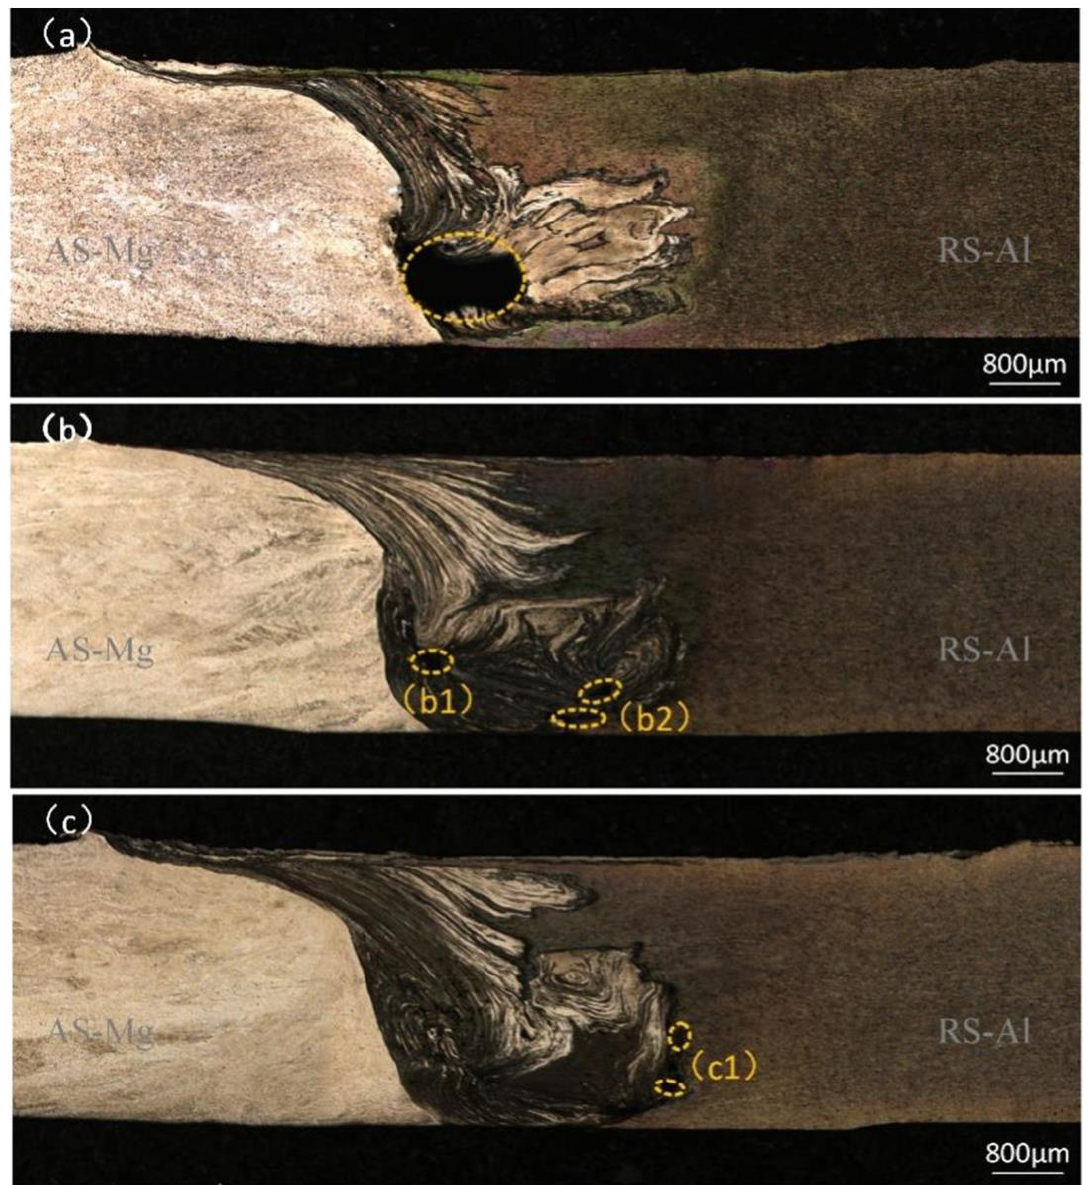
Figure 7. Cross-section view of Al-Mg joint welded by ( a ) 0 A, ( b ) 300 A, and ( c ) 500 A electrical current. Reprinted with permission from ref. [40]. Copyright 2022 Elsevier.